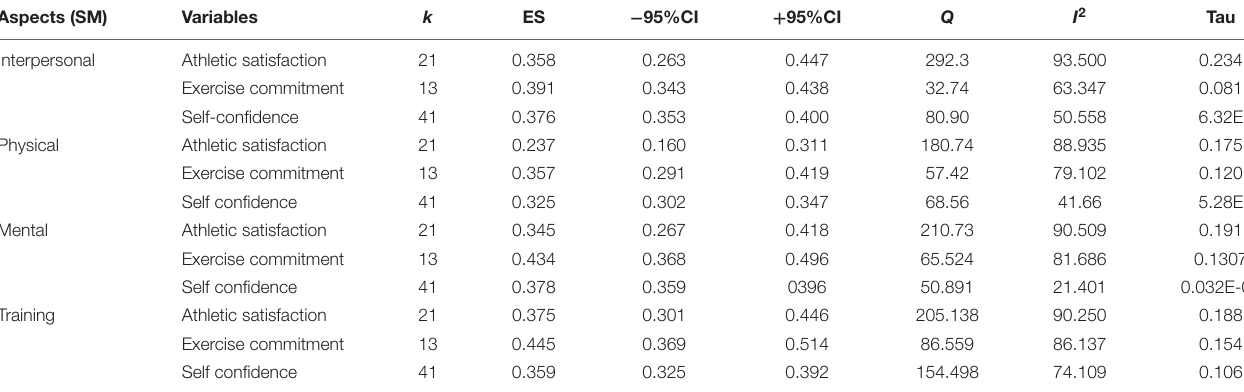
TABLE 3 | Effects of aspects of self-management on psychological outcomes. Aspects